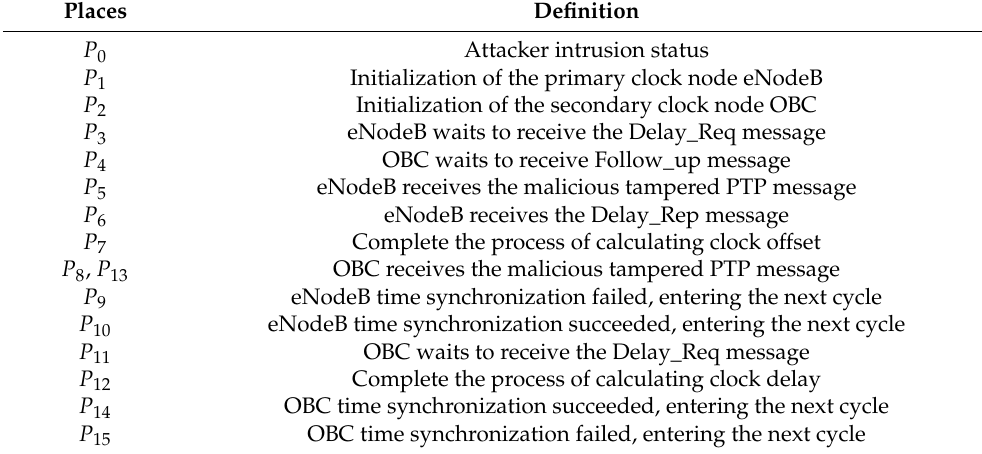
Table 1. Definitions of places.